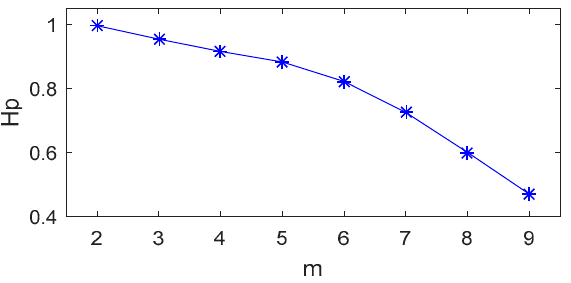
Figure 8. The curve of the calculated value of permutation entropy changing with the embedded dimension. Table 2. The permutation entropy of different load types during normal operations and serial arc fault conditions.